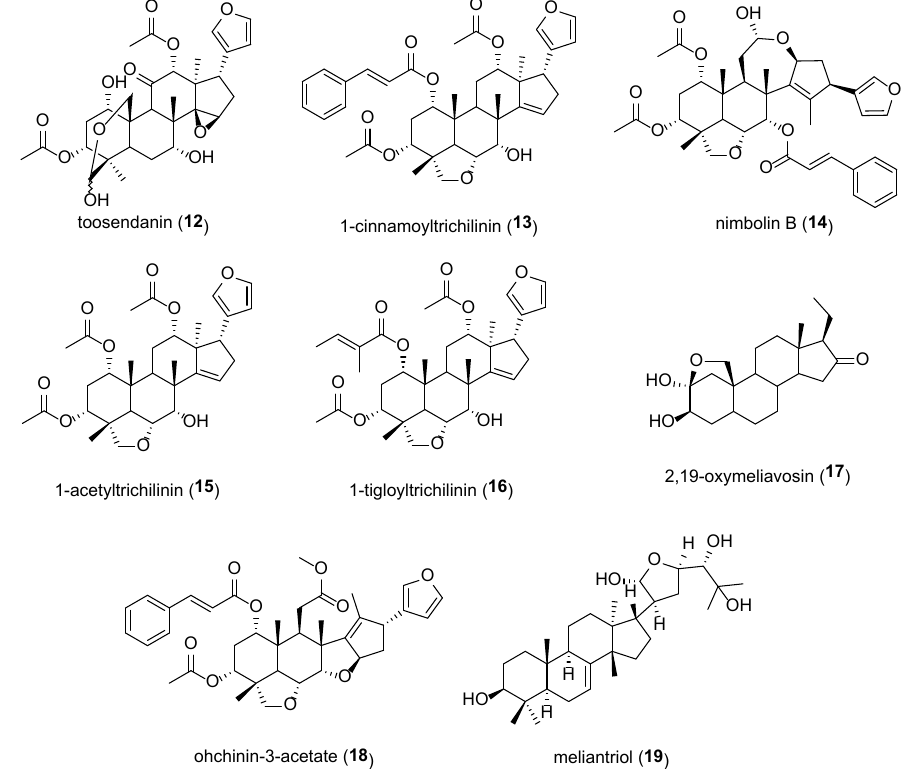
Figure 4. Further chemical structures of compounds isolated from Melia volkensii with antifeedant and growth-inhibition activity against insects.